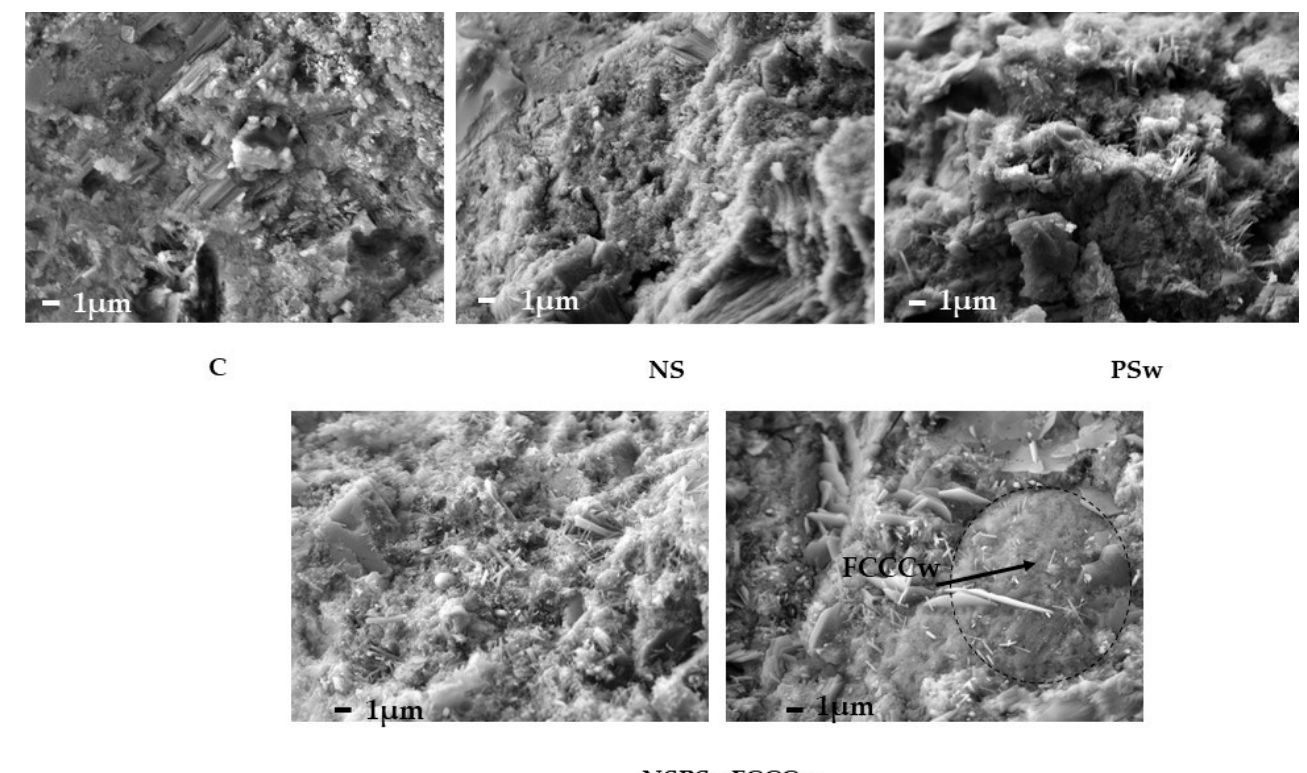
Figure 11. Microstructure images of the most typical batches (magnification 5000